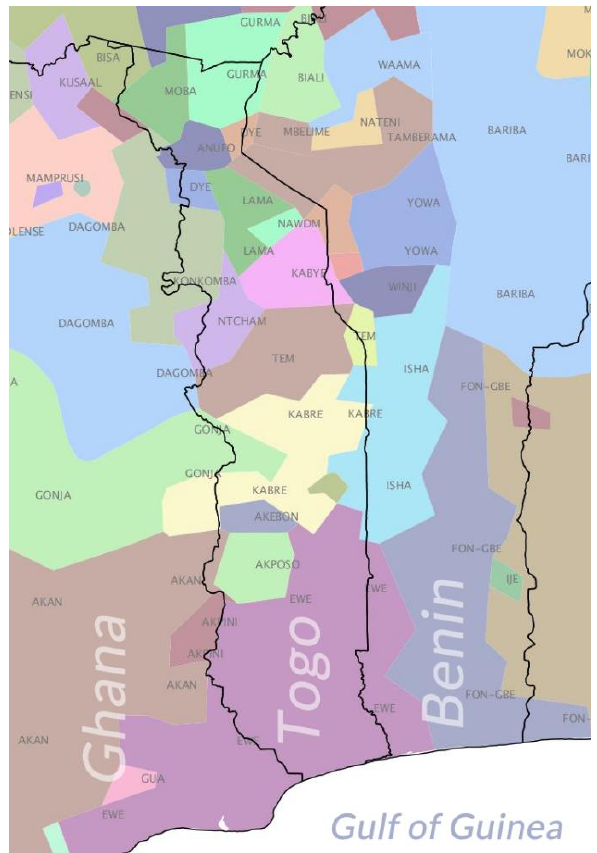
Figure 2. Map of ethnic diversity. (Own elaboration from Worl Map Harward Education,